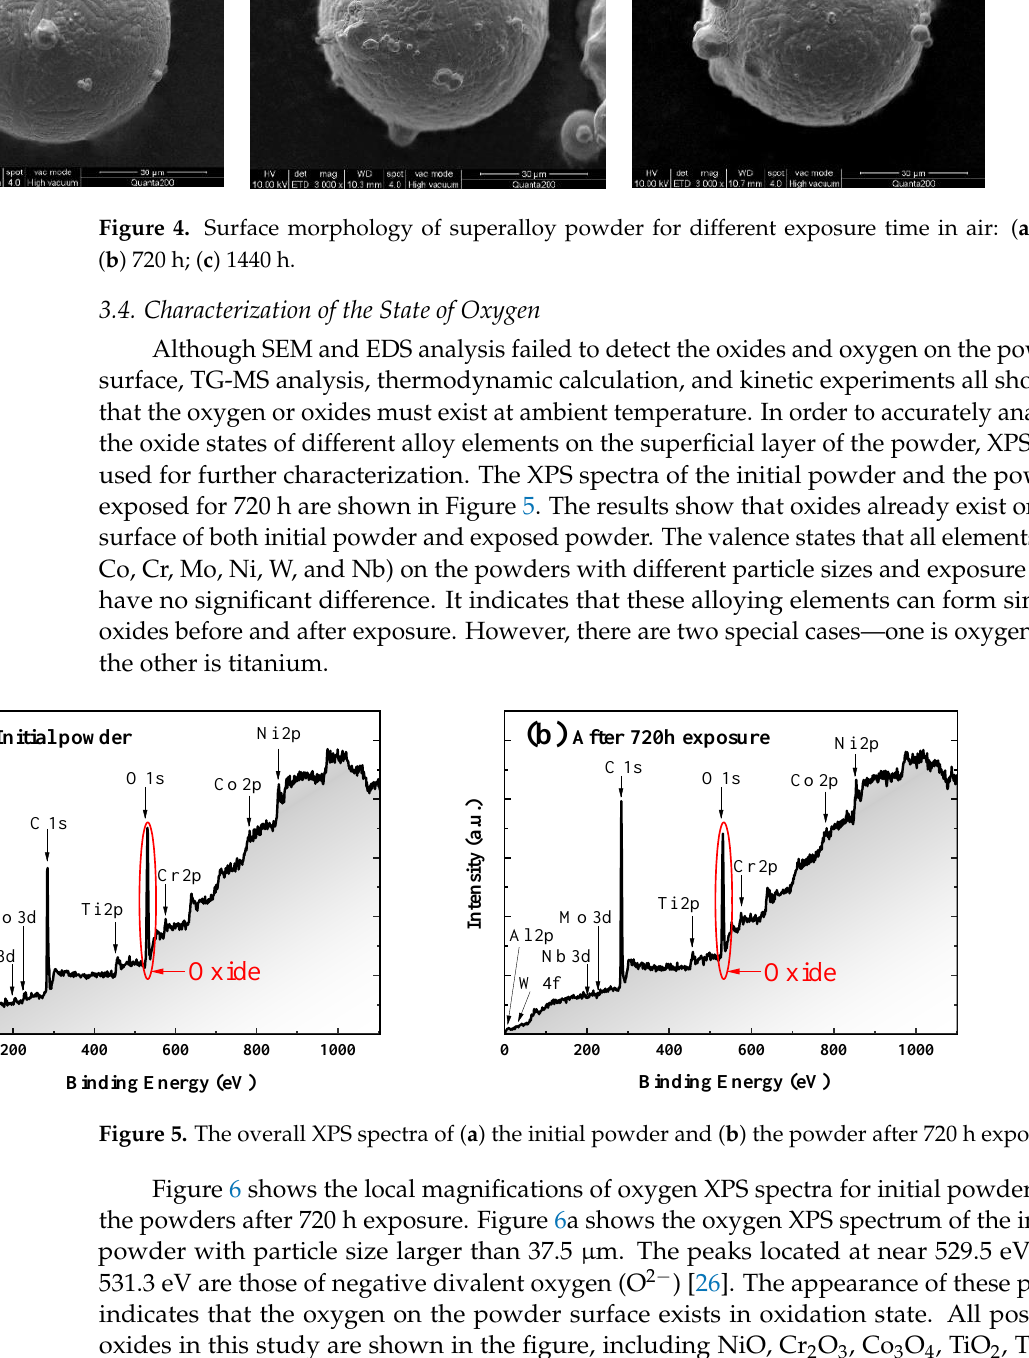
＜ 15μm Figure 3. Oxygen contents of the studied superalloy powder after exposure for different time in air. Figure 4 shows the powder surface morphologies of the powders with particle size about 50 μm after 0 h, 720 h , and 1440 h exposure. There is no significant difference for various exposure time. The composition analysis indicated that the elements distributions